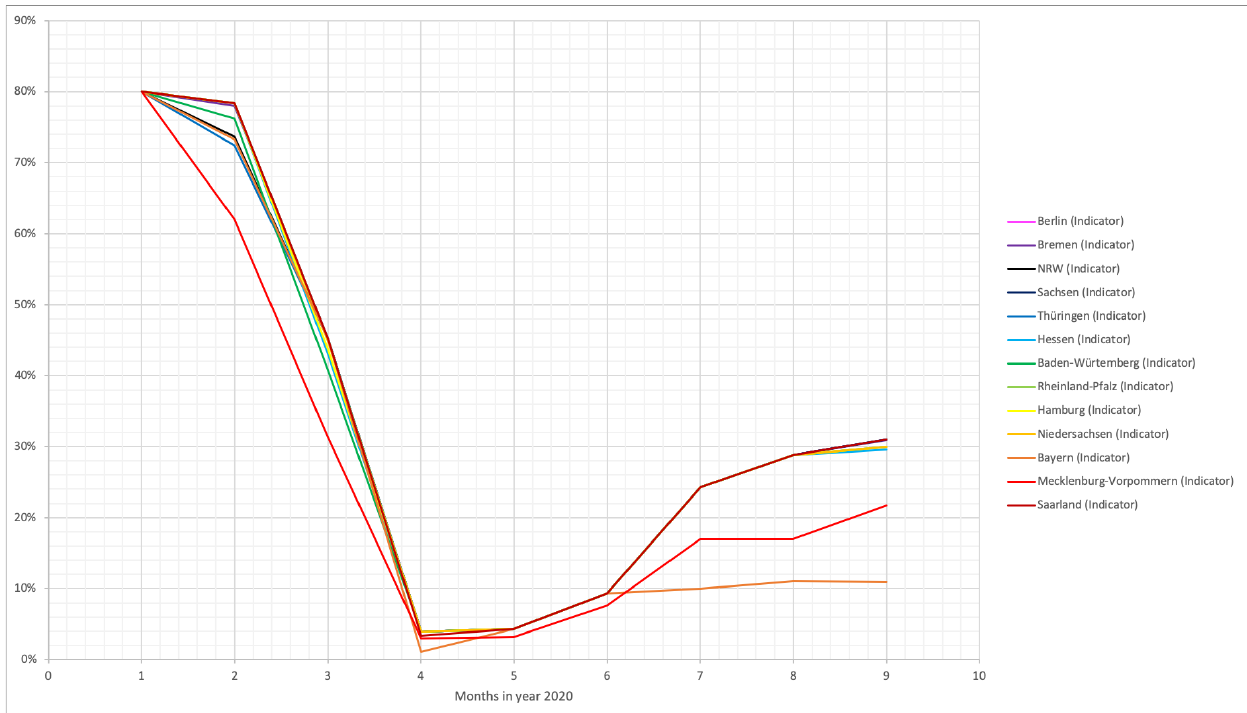
Figure 5. Indicator fitted to the collected data on contact restrictions and flights for